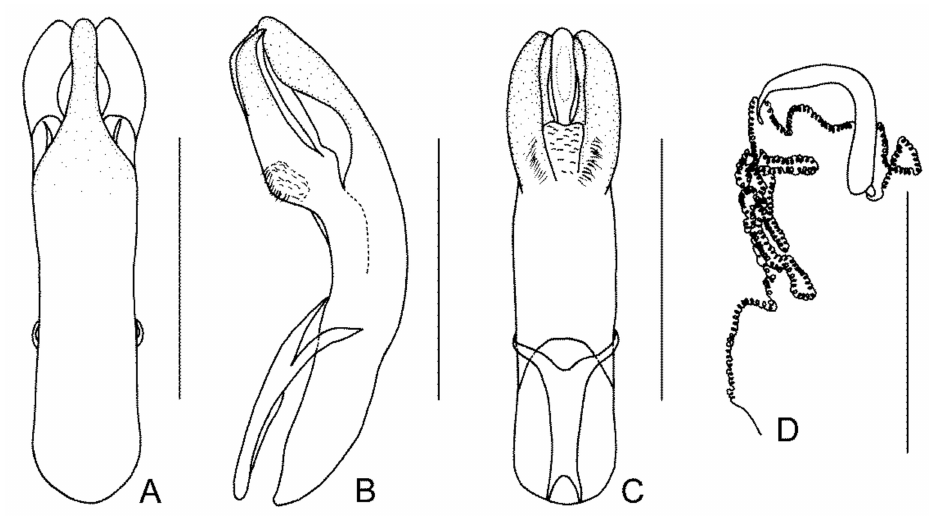
Figure 37. Cryptocephalus ( Burlinius ) vividus Lopatin, 1997: ( A ) dorsal view of aedeagus; ( B )